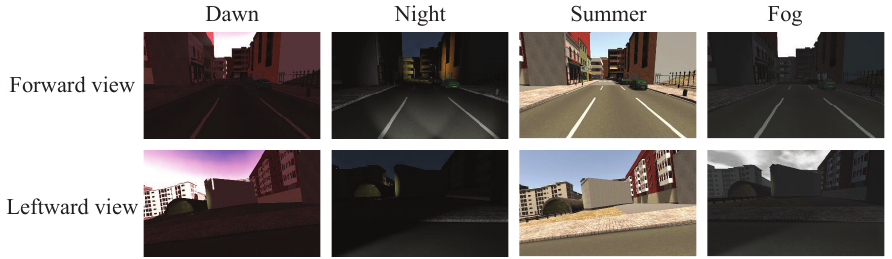
Figure 5. The samples of the forward view and leftward view images with four different appearances: Dawn, Night, Summer, and Fog in the SYNTHIA dataset. They are sampled from the same